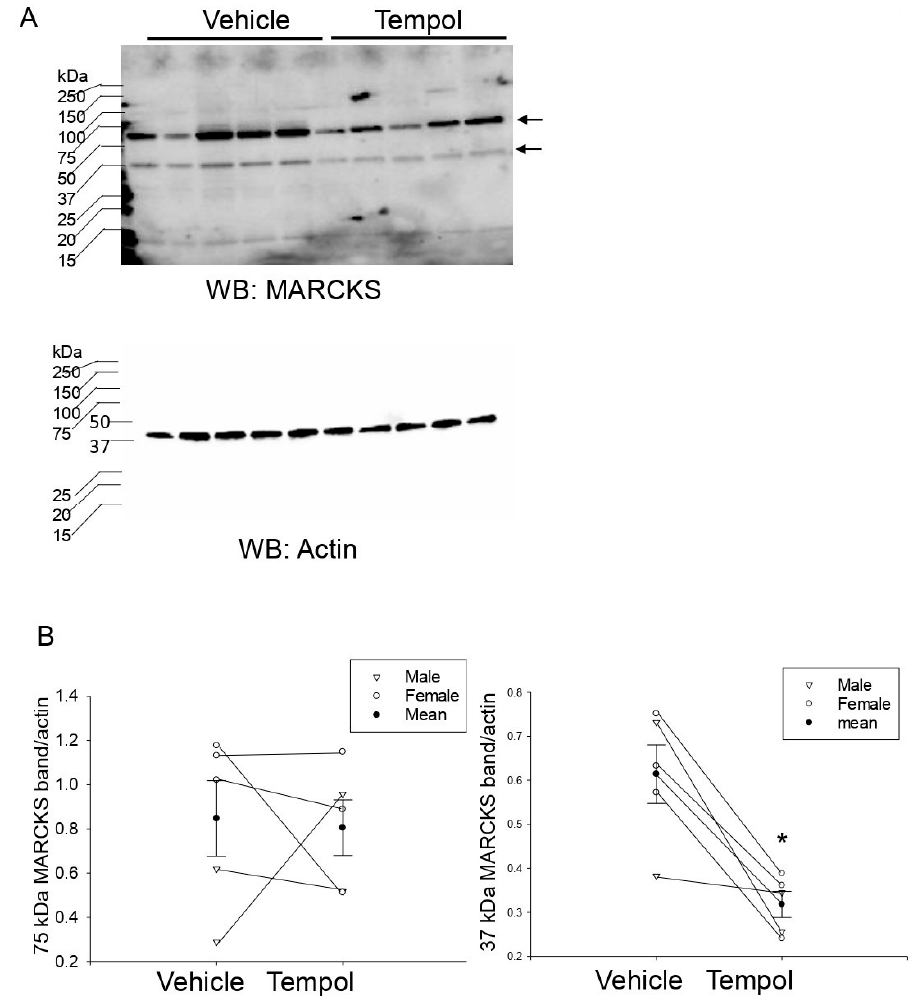
Figure 7. Western blot analysis of MARCKS and MLP1 protein expression in renal kidney cortex tissue of hypertensive 129Sv kidneys infused with vehicle or Tempol: ( A ) Western blot of the MARCKS family of proteins in kidney cortex samples from salt-induced hypertensive 129Sv mice infused with either vehicle or Tempol. ( B ) Densitometric analysis of the immunoreactive MARCKS (75 kDa) band and the MLP1 (37 kDa) band normalized to the actin band in panel A. N = 5 per group. A paired t -test was performed, and * represents a p -value